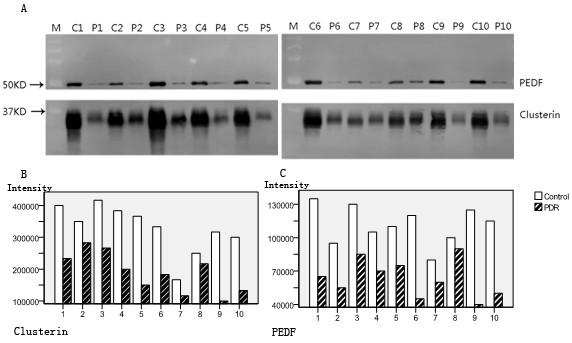
Validation of the downregulation of clusterin and PEDF in the PDR vitreous by Western blot analysis. (A) Western blot analyses of vitreous samples showing lower levels of PEDF (50 kDa) and clusterin (33 kDa) in the vitreous fluid of ten PDR patients. C (control group), P (PDR group), and M (marker). (B) and (C) Densitometric analyses of the vitreous PEDF and clusterin levels. Vitreous PEDF and clusterin levels in the PDR group were lower than those of the control group. (p < 0.01).